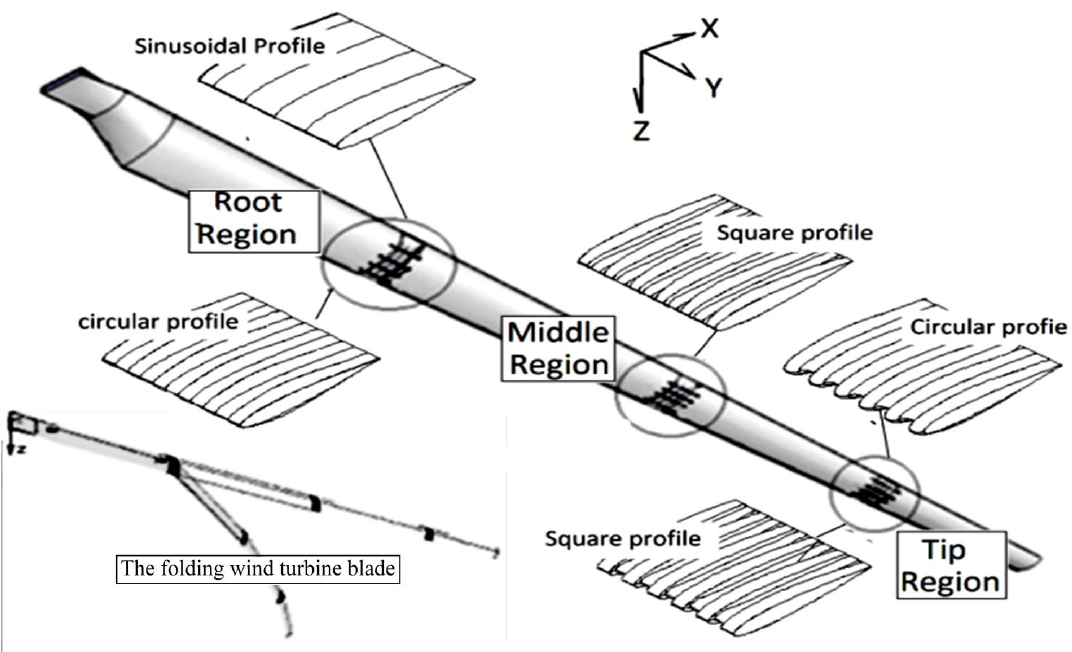
Figure 8. The recommended locations of the flexure hinges at the anthropomorphic wind turbine blade.